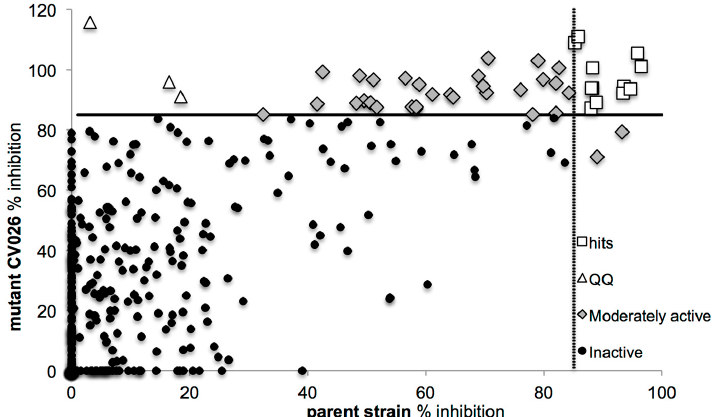
Figure 2. Screening of the flavonoids library ( n = 465) for QS inhibition using the violacein extraction assay. The bactericidal compounds identified using the resazurin assay were excluded from the graph. White squares represent the hits that were active on both strains, grey squares represent the moderately active compounds while the white triangles represent the quorum quenchers (compounds active only on the mutant strain).